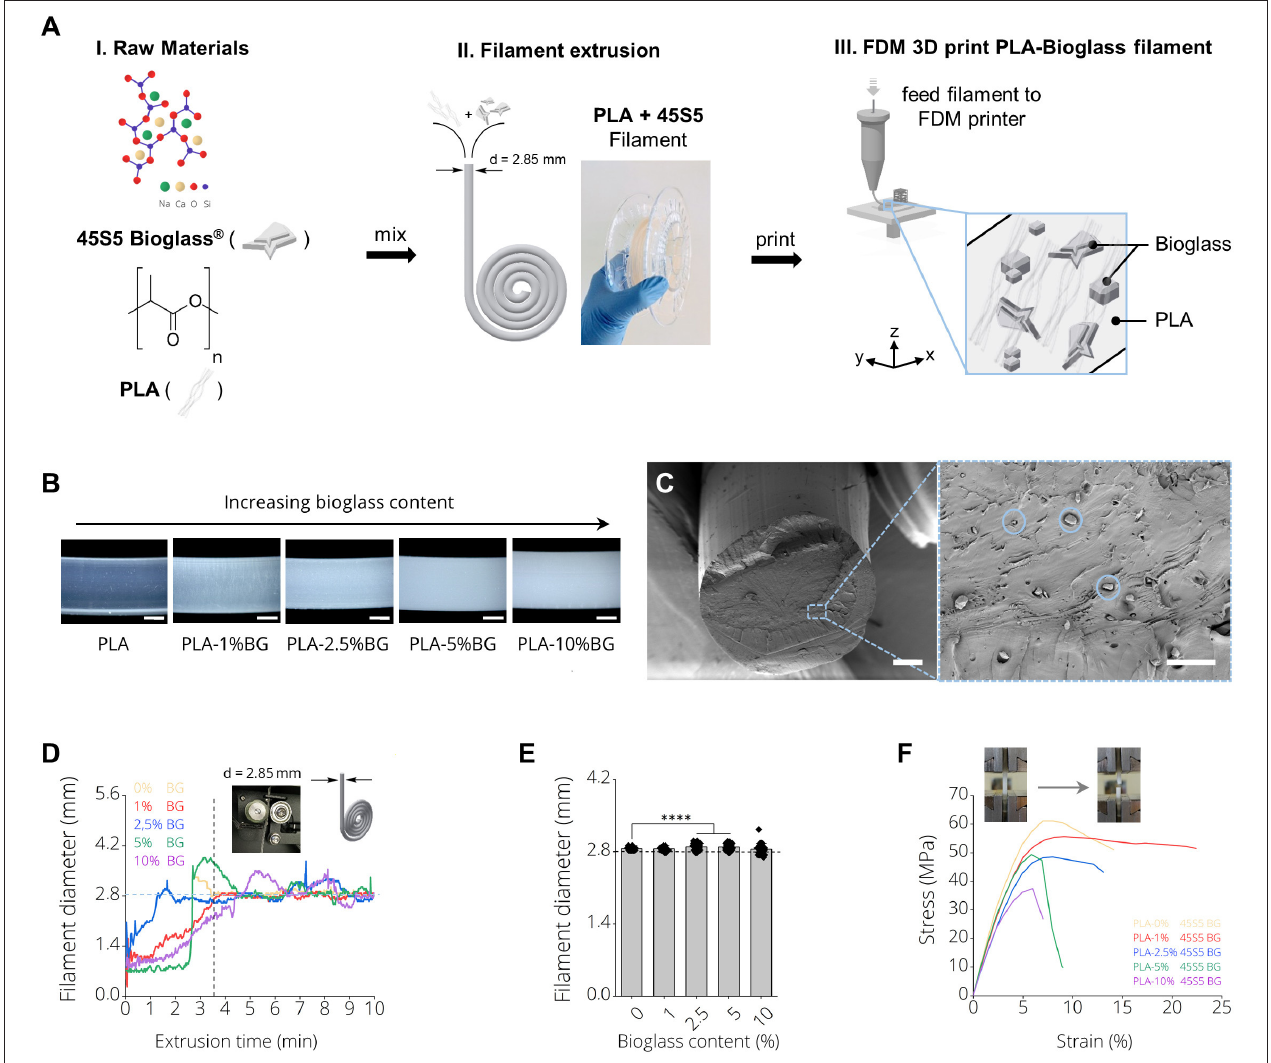
FIGURE 1 | PLA-45S5 BG filaments for fused deposition modeling. (A) Schematic diagram depicting the process pipeline to fabricate PLA-BG FDM printed scaffolds with (i) mixing of the raw materials PLA and 45S5 BG, (ii) filament production using a polymer extruder with an image of the final extruded and spooled 45S5